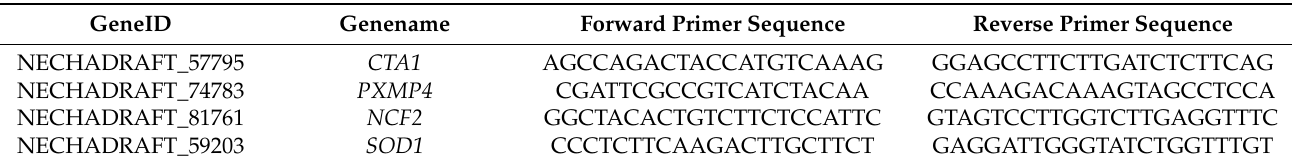
Table 1. List of oligonucleotide primers used for RT-qPCR